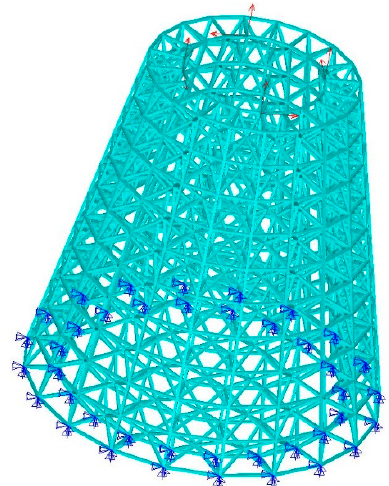
Figure 16. Boundary conditions and loading for hollow round platform.